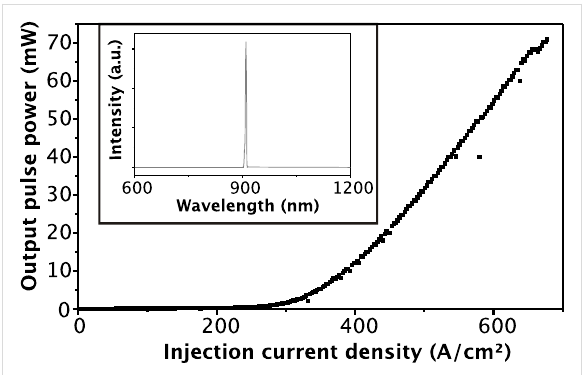
Figure 5: Output pulse power versus injection current density of a laser with a 1000 µm long and 30 µm wide active region, operated in pulsed mode (1 µs pulse width and a duty cycle of 0.1%) at an oper- ating temperature T Laser = 84 K. The threshold current density and quantum efficiency were j th = 356 A/cm 2 and η d = 0.542, respectively. The inset shows the emission spectrum at j = 1.22 × j th revealing an emission wavelength of λ Laser = 0.909 µm. The cavity length and width were 1000 and 30 µm, respectively. At an operating